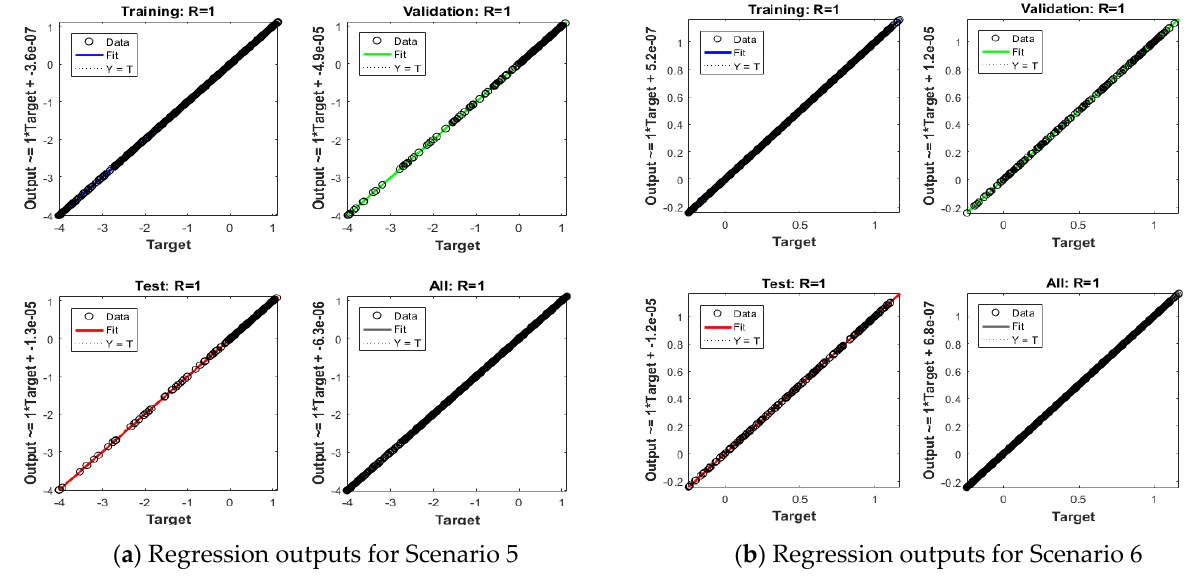
Figure 12 : Regression performance of the proposed TLMB-NN for solving HTM-BFN model with MHD of Scenarios 5 and 6.